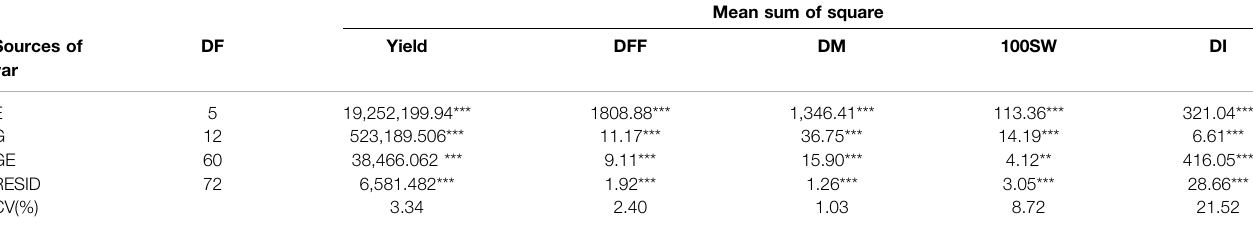
TABLE 2 | Analysis of joint variance for the trait yield (Per hectare), days to fi fty per cent fl owering (DFF), days to maturity (DM), 100 seed weight (100SW) and disease incidence (DI) evaluated in 13 genotypes in a different environment (**, signi fi cant at p ≤ 0.01; ***, signi fi cant at p ≤ 0.001.) Mean sum of